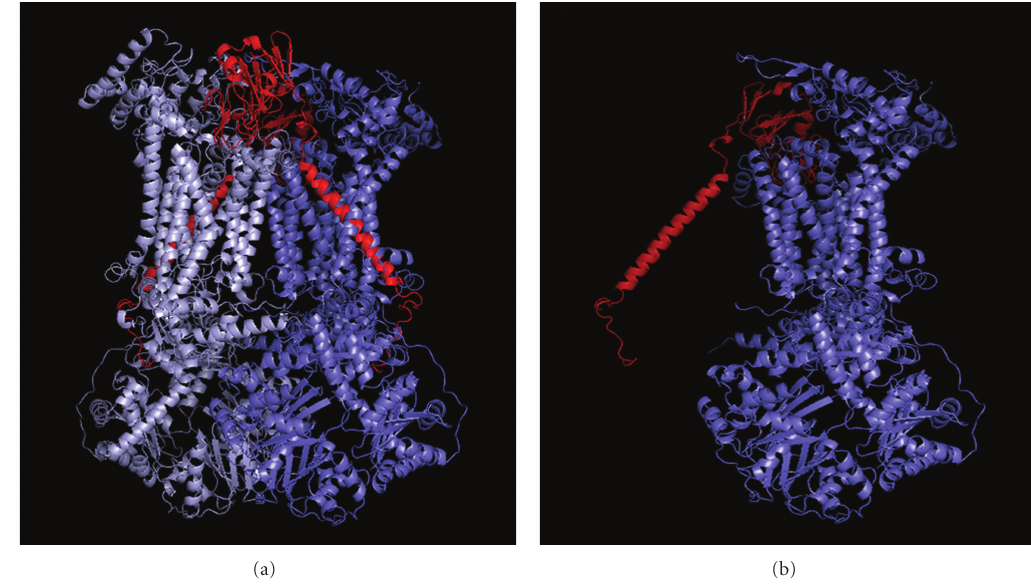
Figure 1: Topology of ISP in the yeast cytochrome bc 1 complex. (a) The arrangement of the Rieske protein in the bc 1 complex homodimer. The subunits in the cytochrome bc 1 dimer are depicted as ribbons, with subunits in one monomer colored grey and subunits in the other monomercolored cyan. ISPs of the two monomersare colored red. (b) Panel B shows the spatial arrangement of ISP (red) in one cytochrome bc 1 monomer (cyan), in order to highlight its transdimeric